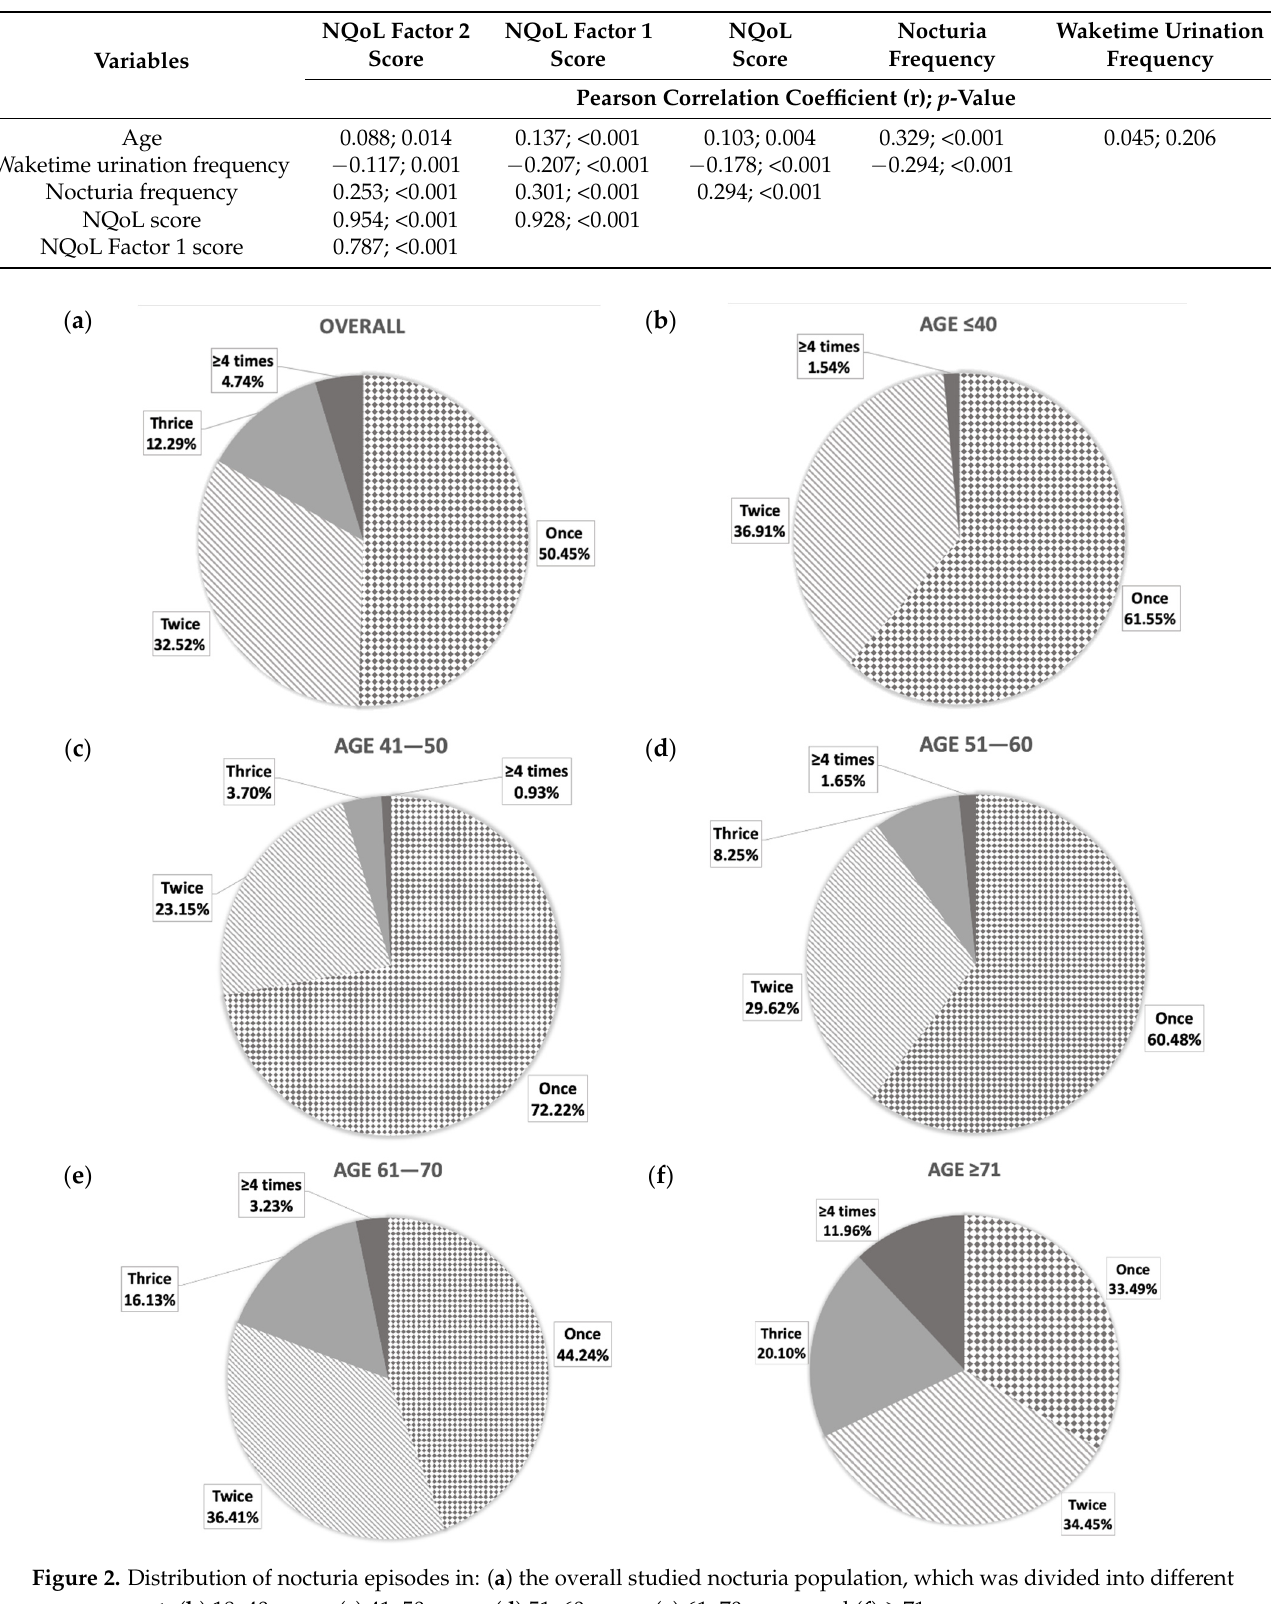
Table 3. Correlational relationships between continuous variables.